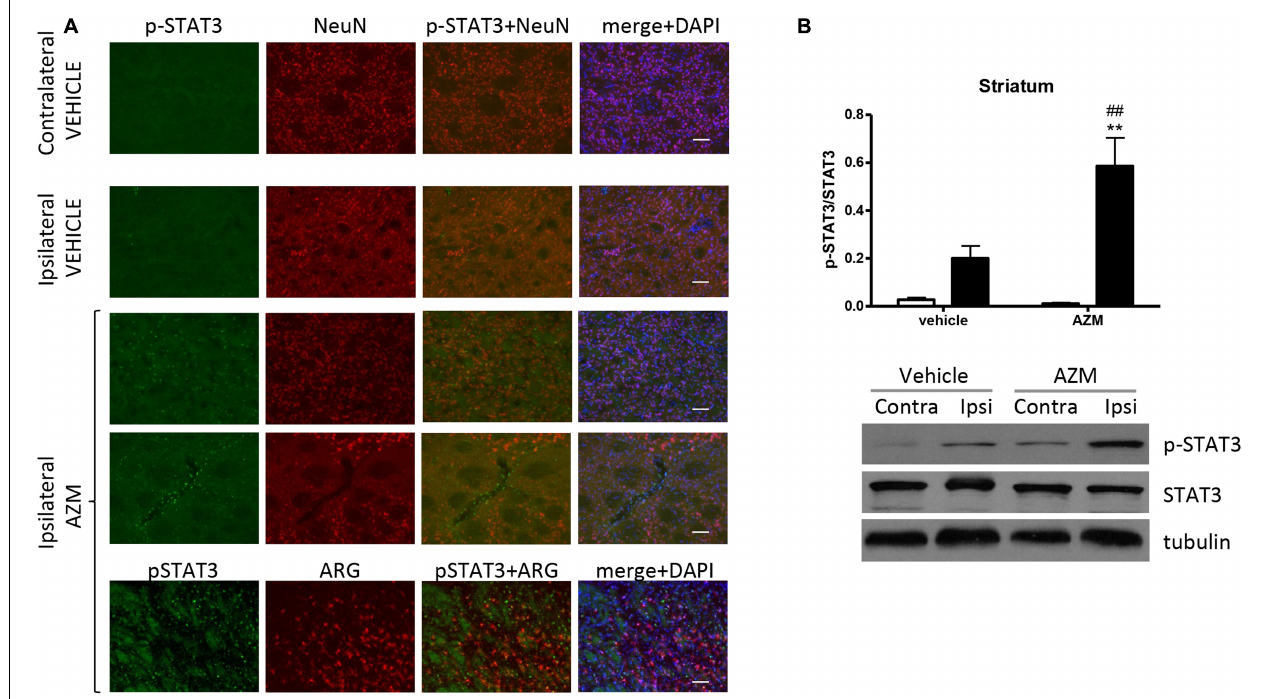
FIGURE 5 | Azithromycin elevates STAT3 phosphorylation in the ischemic striatum of rats subjected to 2 h MCAo followed by 22 h of reperfusion. (A) Representative immunofluorescence images of the contralateral and ipsilateral (ischemic) striatum of rats subjected to transient MCAo showing expression of p-STAT3 in some NeuN-positive neurons of the ischemic hemisphere. An increased number of p-STAT3 immunopositive cells can be observed in the ispilateral striatum of rats treated with azithromycin (AZM), being the signal mainly coincident with infiltrating leukocytes and arginase 1 (ARG)-immunopositive cells (lower panels), namely microglia/macrophages displaying an M2 phenotype. Scale bars = 70 µ m. (B) Western blot analysis of phospho-STAT3 (Tyr705) (p-STAT3), total STAT3 and tubulin performed on brain homogenates from the ipsilateral (Ipsi, dark bars) and contralateral (Contra, white bars) striatum. Rats were treated with vehicle (0.9% NaCl) or azithromycin (AZM, 150 mg/kg), i.p., upon reperfusion. Data from the densitometric analysis of the autoradiographic bands are expressed as mean ± SEM of four independent experiments ( n = 4 rats per experimental group); ∗∗ P < 0.01 vs. vehicle ipsilateral and ## P < 0.01 vs. AZM contralateral (two-way ANOVA for repeated measures followed by Bonferroni